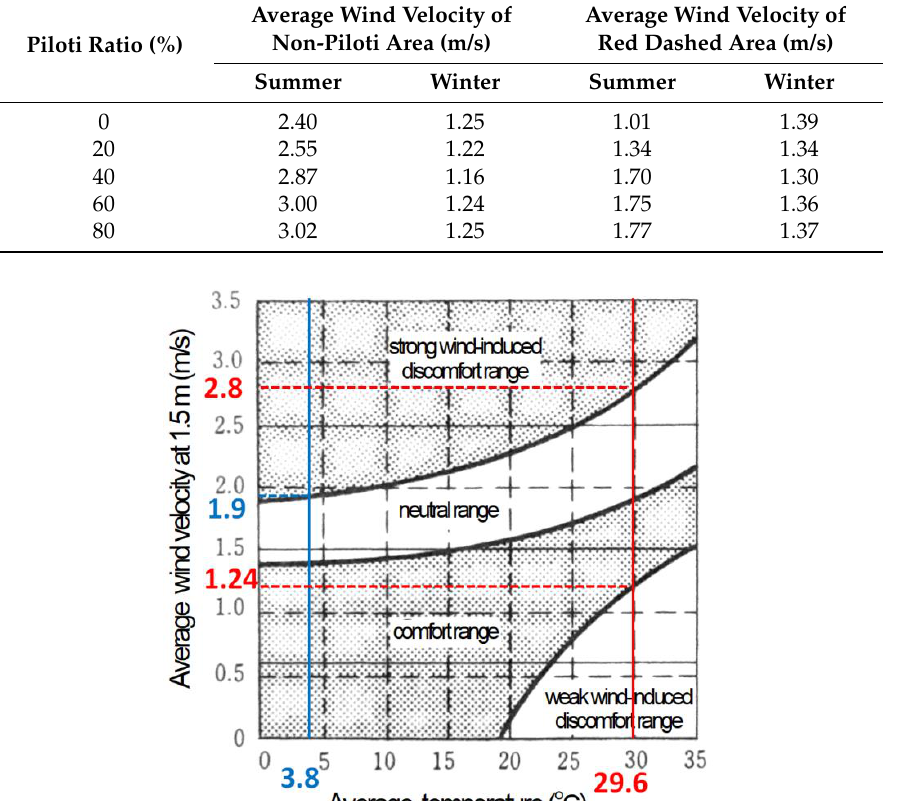
Figure 11. The criteria for assessing the wind-induced discomfort considering the temperature effect.